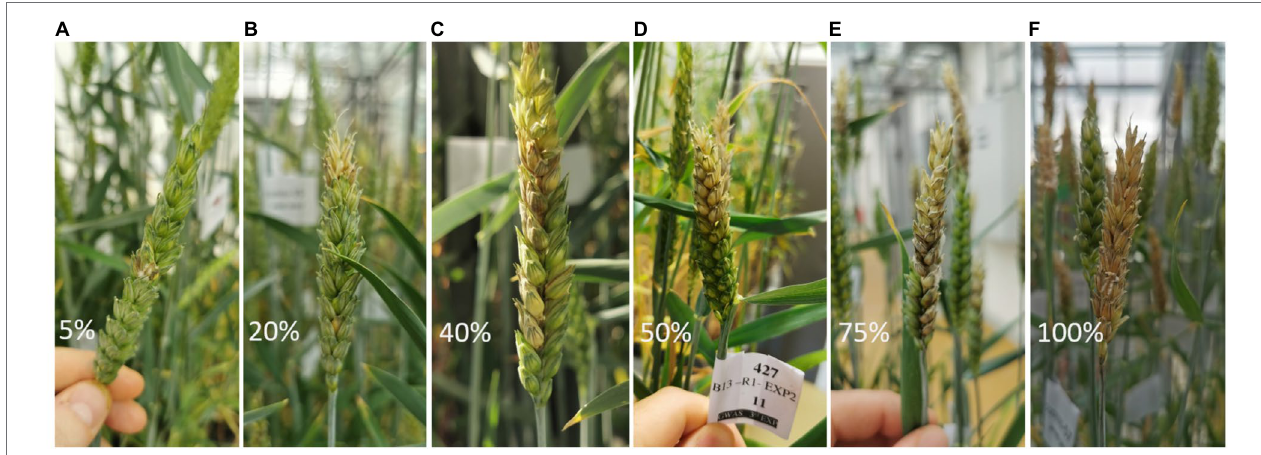
FIGURE 1 | Scale for Fusarium head blight (FHB) severity scoring on winter wheat spike. Rating of disease severity ranged from (A) 5 to (F) 100%. FHB infection can be continues (B, D) or disconnected (C, E) on a spike. Scoring was based on the proportion of total infected spikelets to the total numbers of